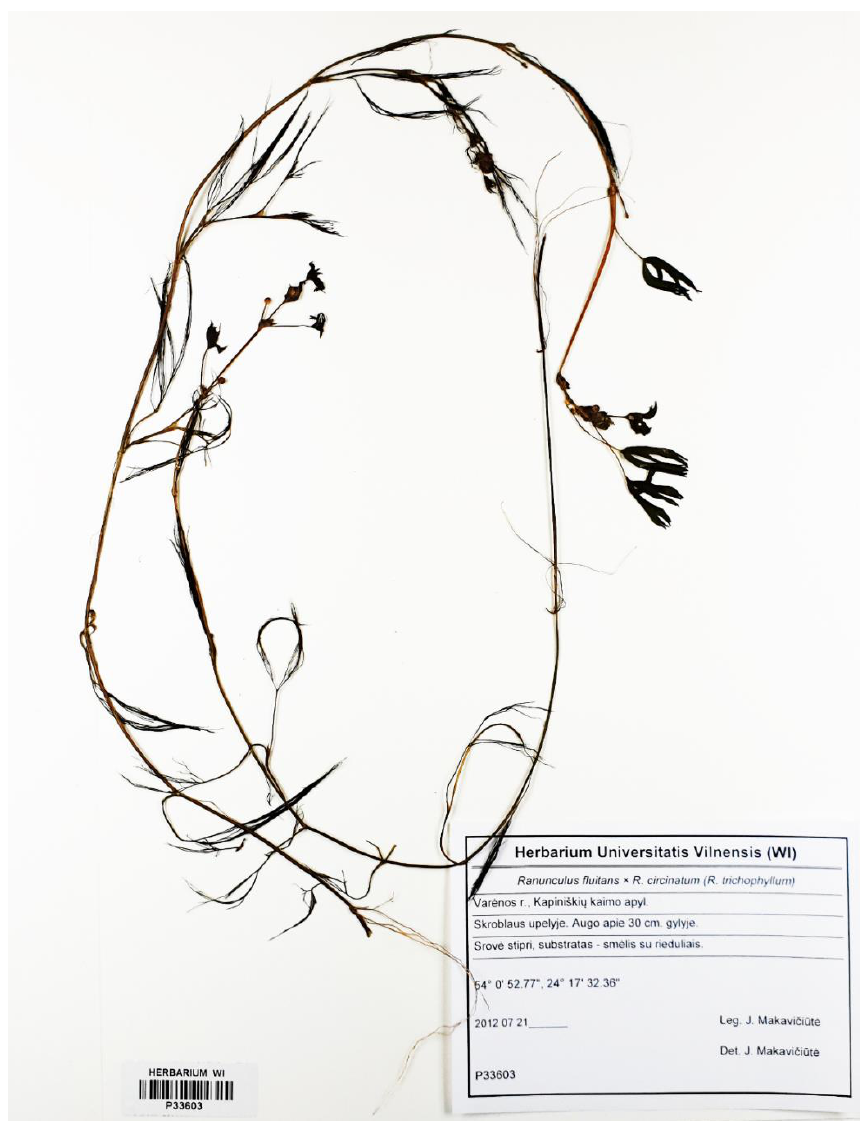
Figure 5. General appearance of putative Ranunculus hybrid with capillary and intermediate leaves from the Skroblus River.